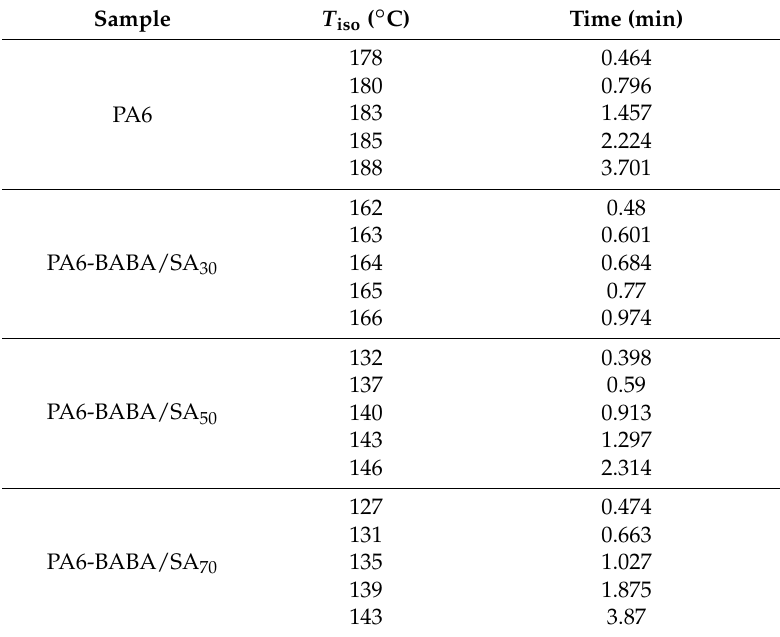
Table 3. Isothermal crystallization kinetic temperatures ( T ) and crystallization times (min) for neat PA6 and